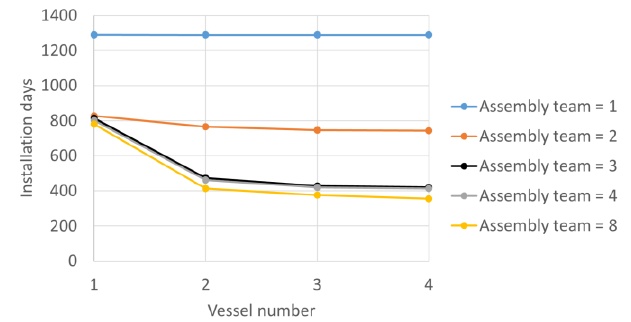
Fig. 14. Installation time against number of vessels for various numbers of assembly teams, in the case of c/d time 2.5 hr.